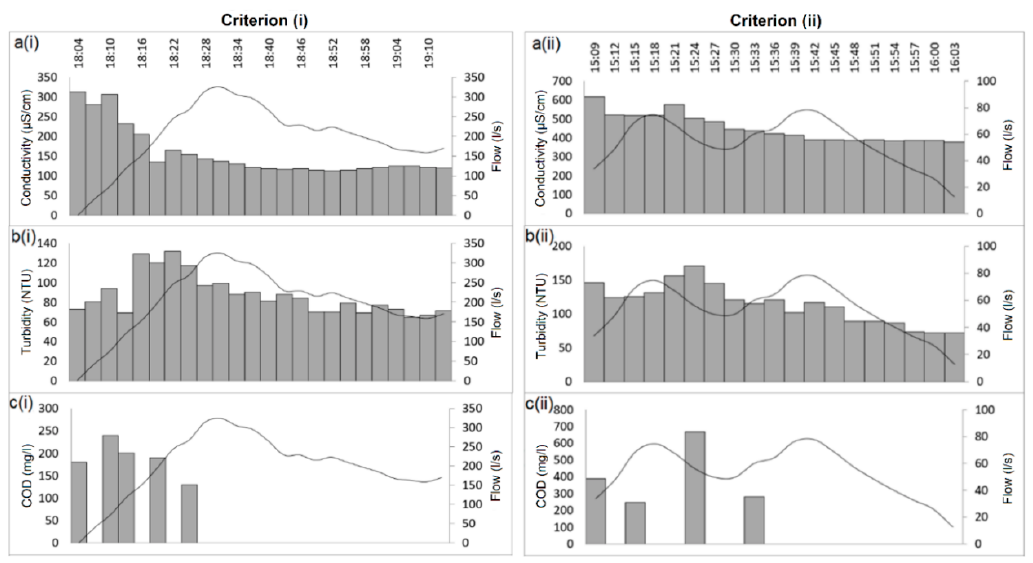
Figure 5. Variation of water quality parameters over time in the El Vado CSO. Criterion ( i ) event with BOD 5 and COD values close to the mean. Criterion ( ii ) event with high BOD 5 and COD values. ( a ) conductivity, ( b ) turbidity and ( c ) COD.